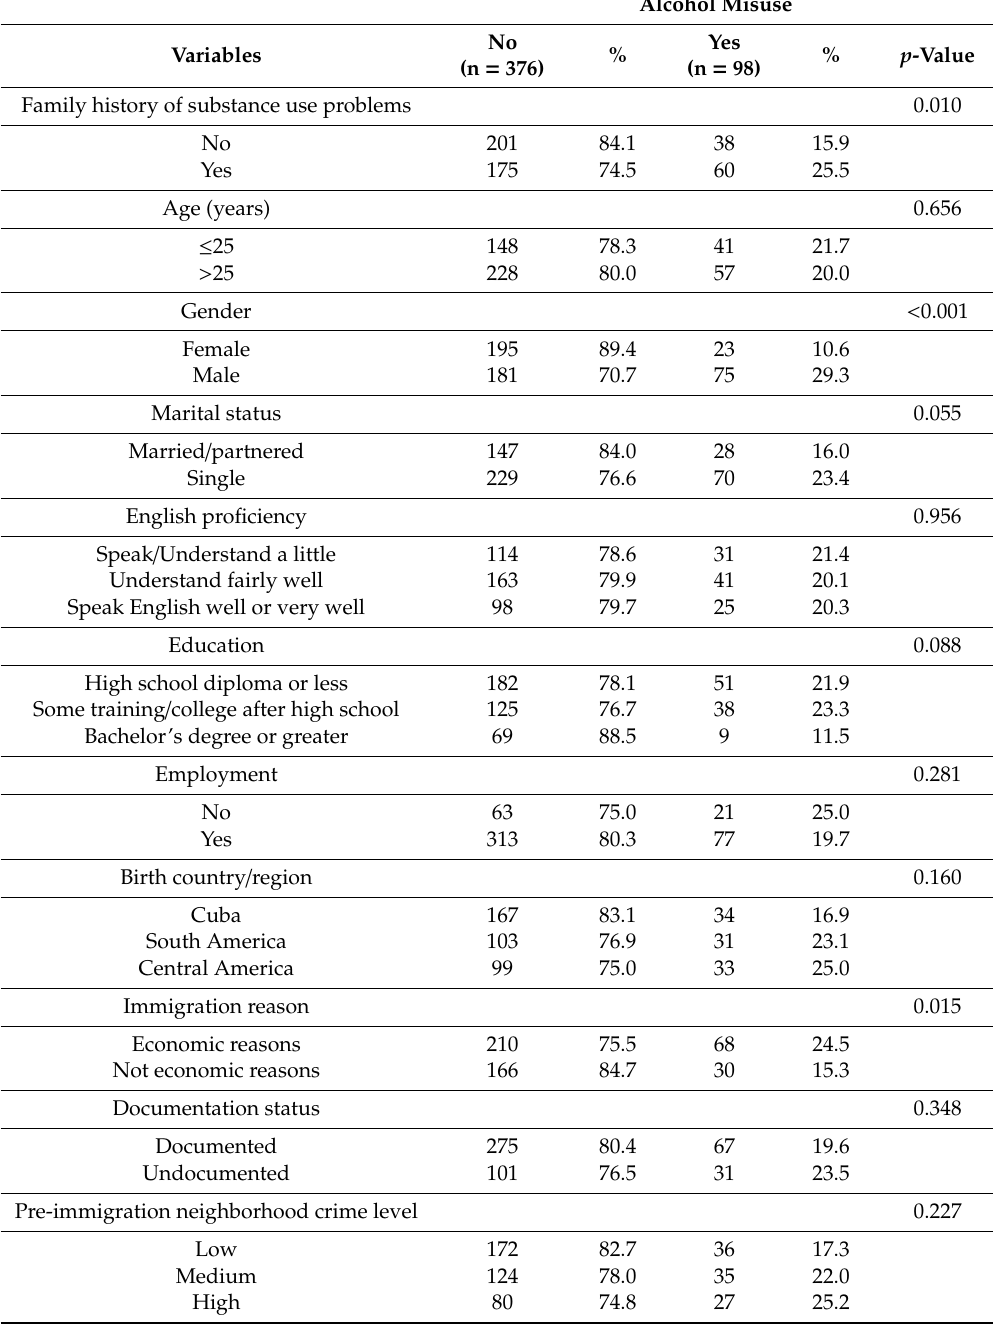
Table 3. Characteristics of recent Latino immigrants with or without alcohol